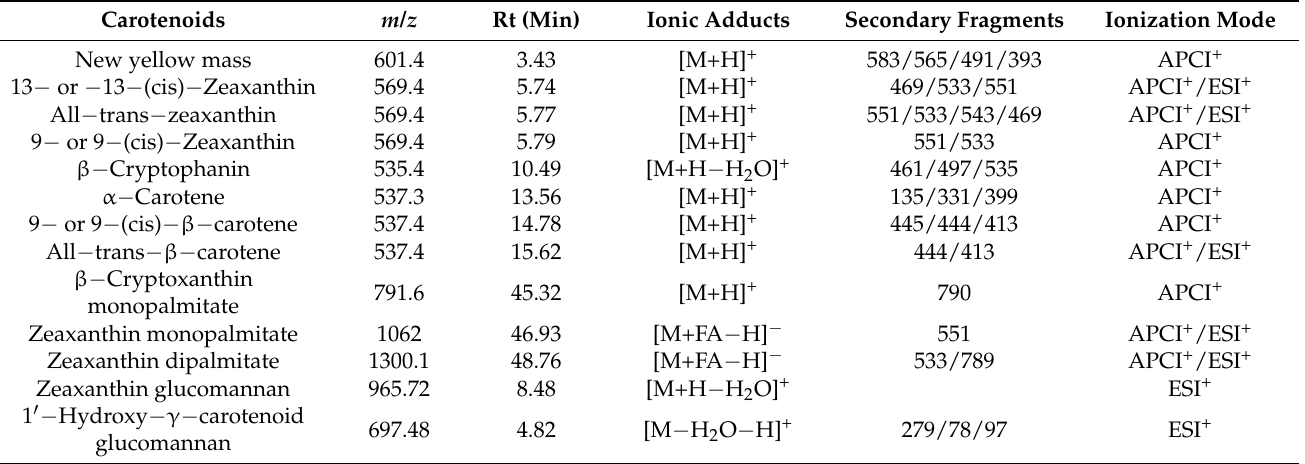
Table 1. Mass spectrometric characteristics of carotenoids and their esters in LBL acquired in LC − Q − TOF − MS/MS with APCI + and ESI +